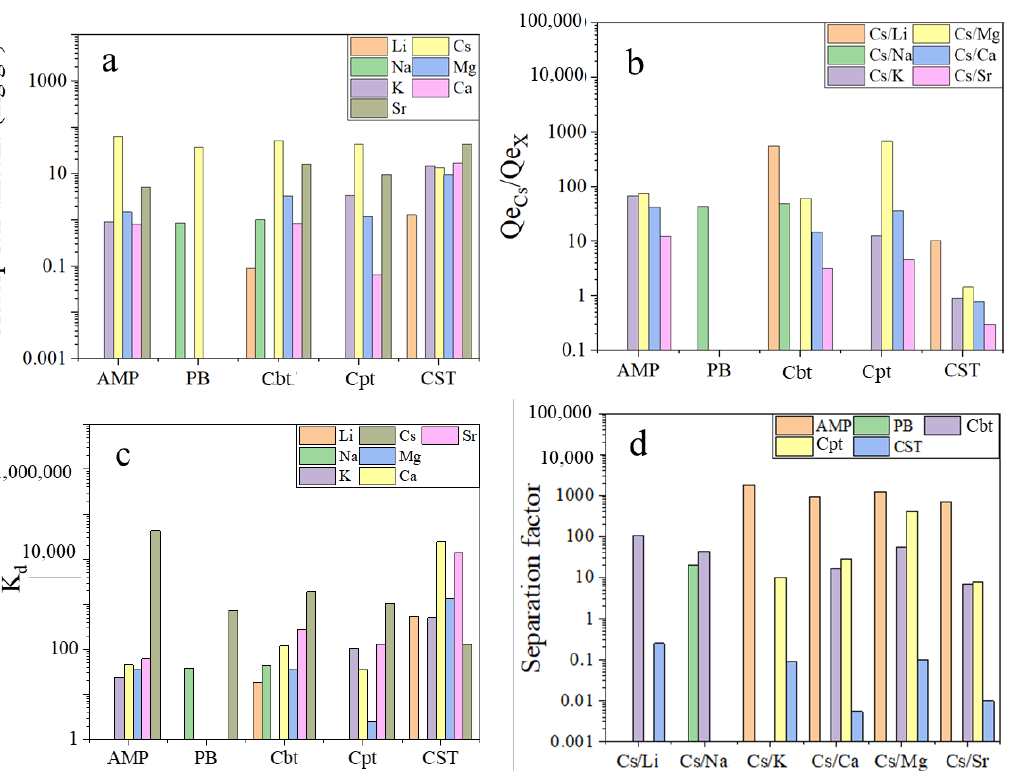
Figure 3. ( a ). Adsorption amount of adsorbents in mixed solution. ( b ). Ratio of adsorption amount of cesium to other elements. ( c ). Distribution coefficient. ( d ). Separation factor.